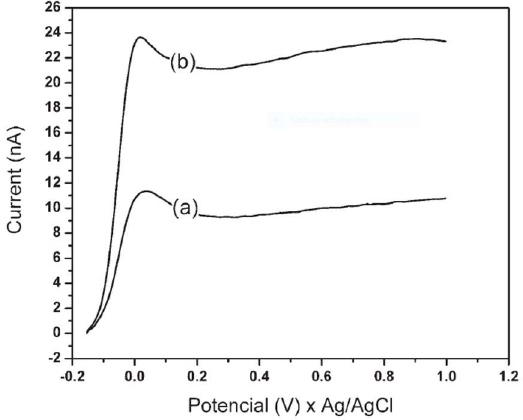
Figure 7. Linear voltammograms at copper microelectrode in phosphate buffer in the absence (a) and in the presence (b) of glyphosate (Gly) 1.45 mol L − 1 (Reprinted with permission from Ref. [114]. Copyright 2007 WILEY-V C H VERLAG